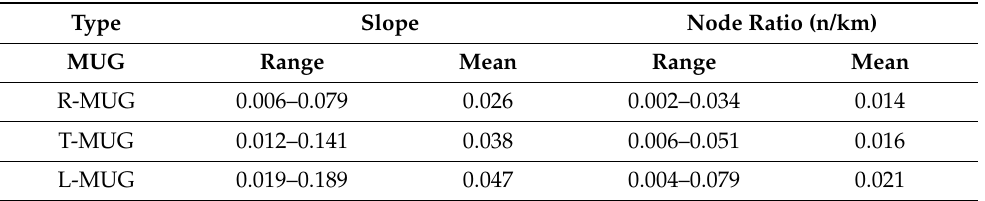
Table 4. Environmental features of the MUG.